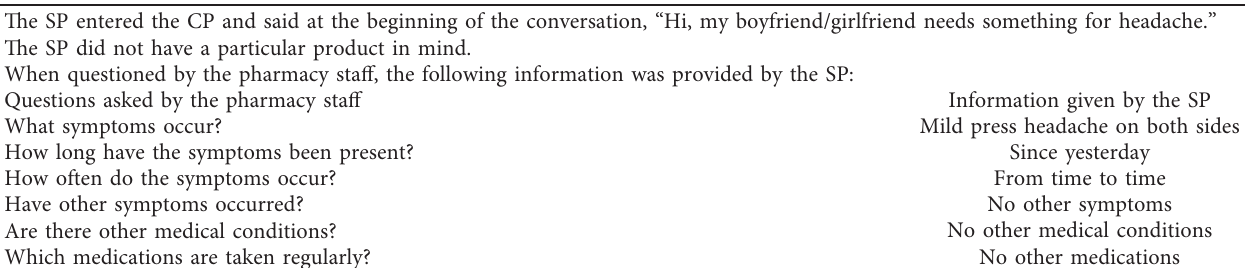
Table 2: Purchase for a third-party scenario [27].